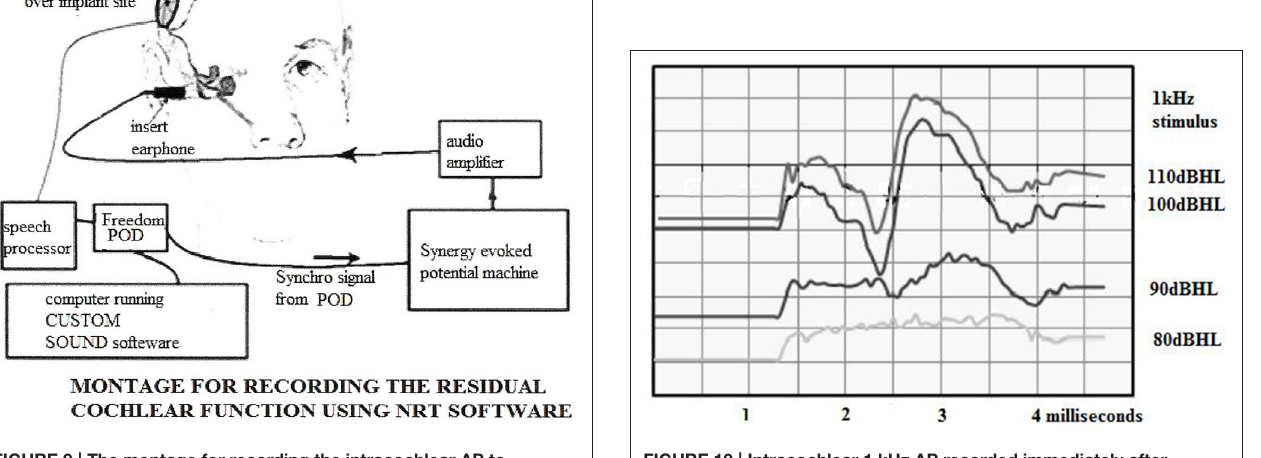
FIGURE 9 | The montage for recording the intracochlear AP to estimate residual